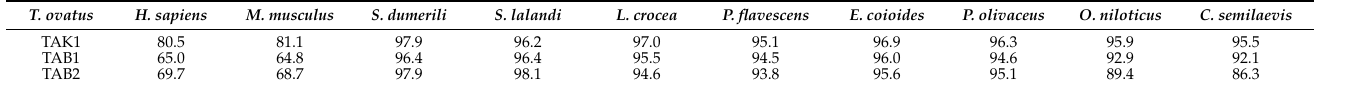
Table 2. The identities (%) between the three genes’ amino acid sequence and other vertebrates.